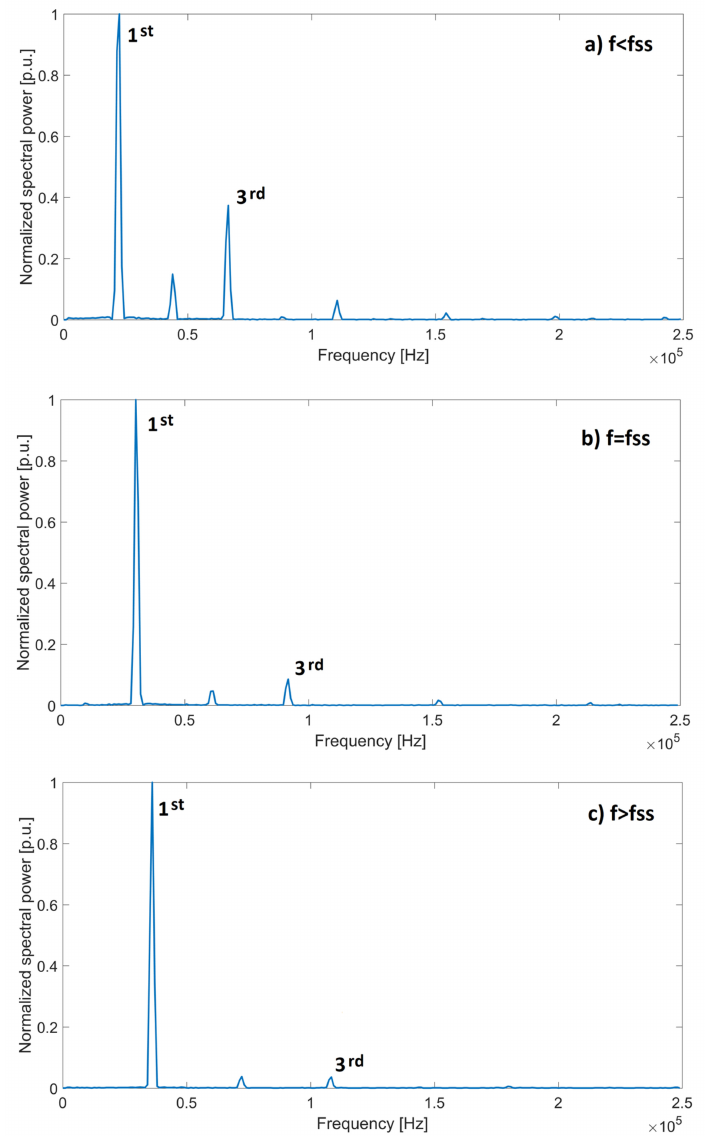
Figure 12. Fast Fourier transform (FFT) of the output voltage signals of Figure